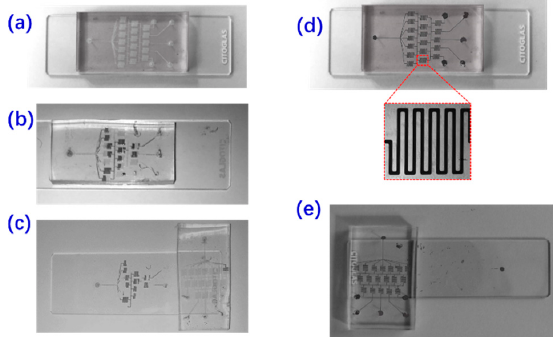
Figure 2. E ff ect of the surface treatment on the micro-casting fabrication performance. ( a ) The patterned PDMS microchannel as the casting mold; ( b ) the microchannel failed to be completely filled with the melting metal if the inner wall was not treated with surfactant; ( c ) the metal-in-PDMS electrode pattern layer failed to be peeled o ff from the glass substrate if the inner wall was not treated with surfactant; ( d ) the microchannel was completely filled with the melting metal, if the inner wall was well treated; ( e ) the metal-in-PDMS electrode pattern layer was peeled o ff from the glass substrate, if the inner wall was well treated with